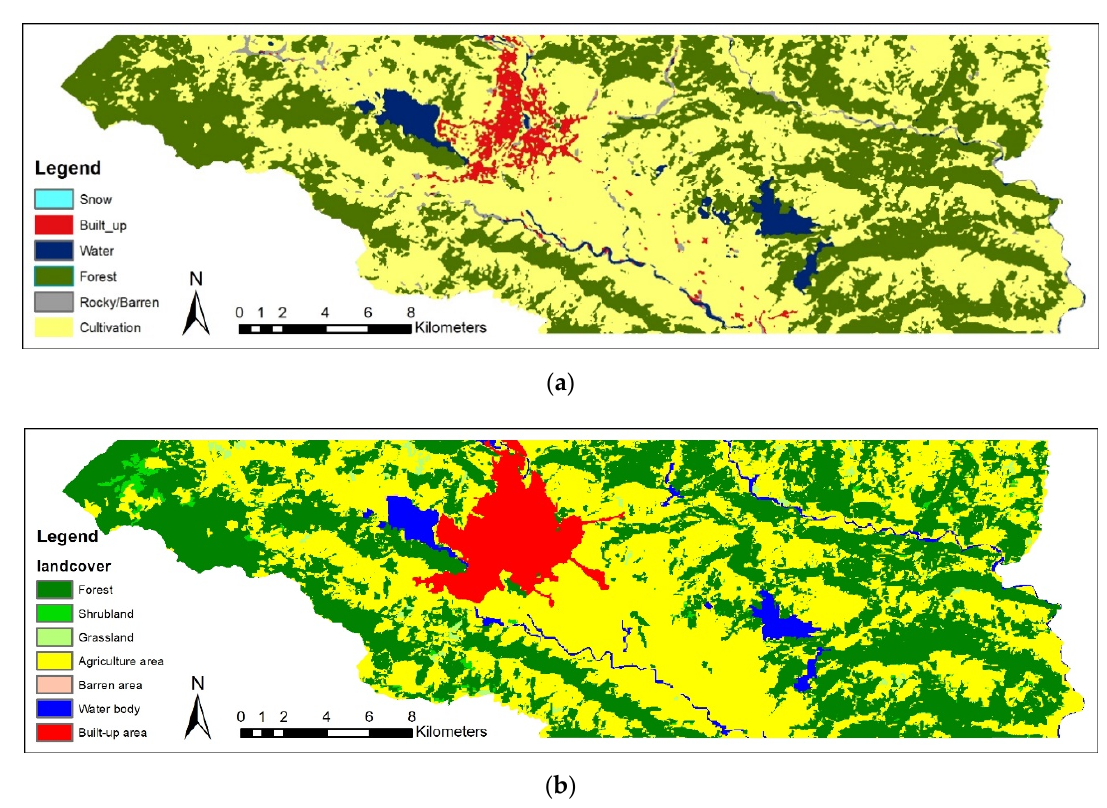
Figure 11: LC map of Pokhara area of the year 2010: ( a ) Map obtained from our study procedure; ( b ) map prepared by ICIMOD.